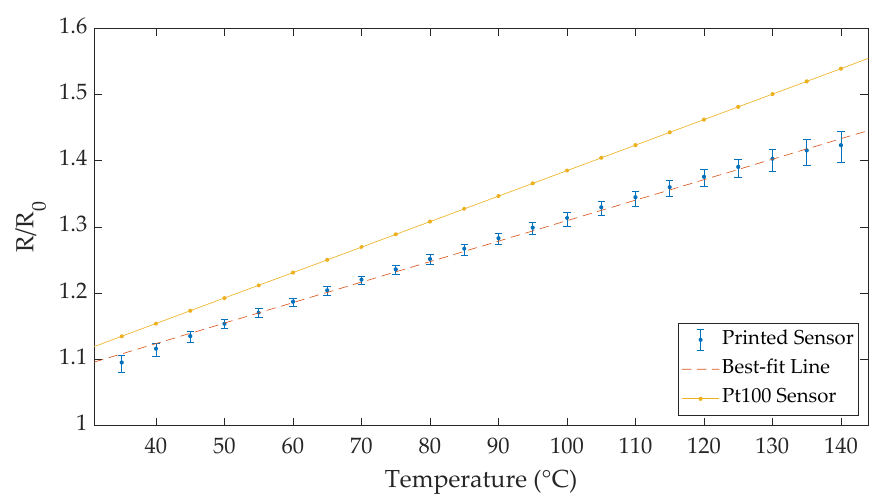
Figure 9. Normalized resistance vs. temperature of the silver sensor (66 mm long) and Pt100 sensor. R 0 is the resistance at 0 °C. Error bars correspond to the output range of eight different sensors.